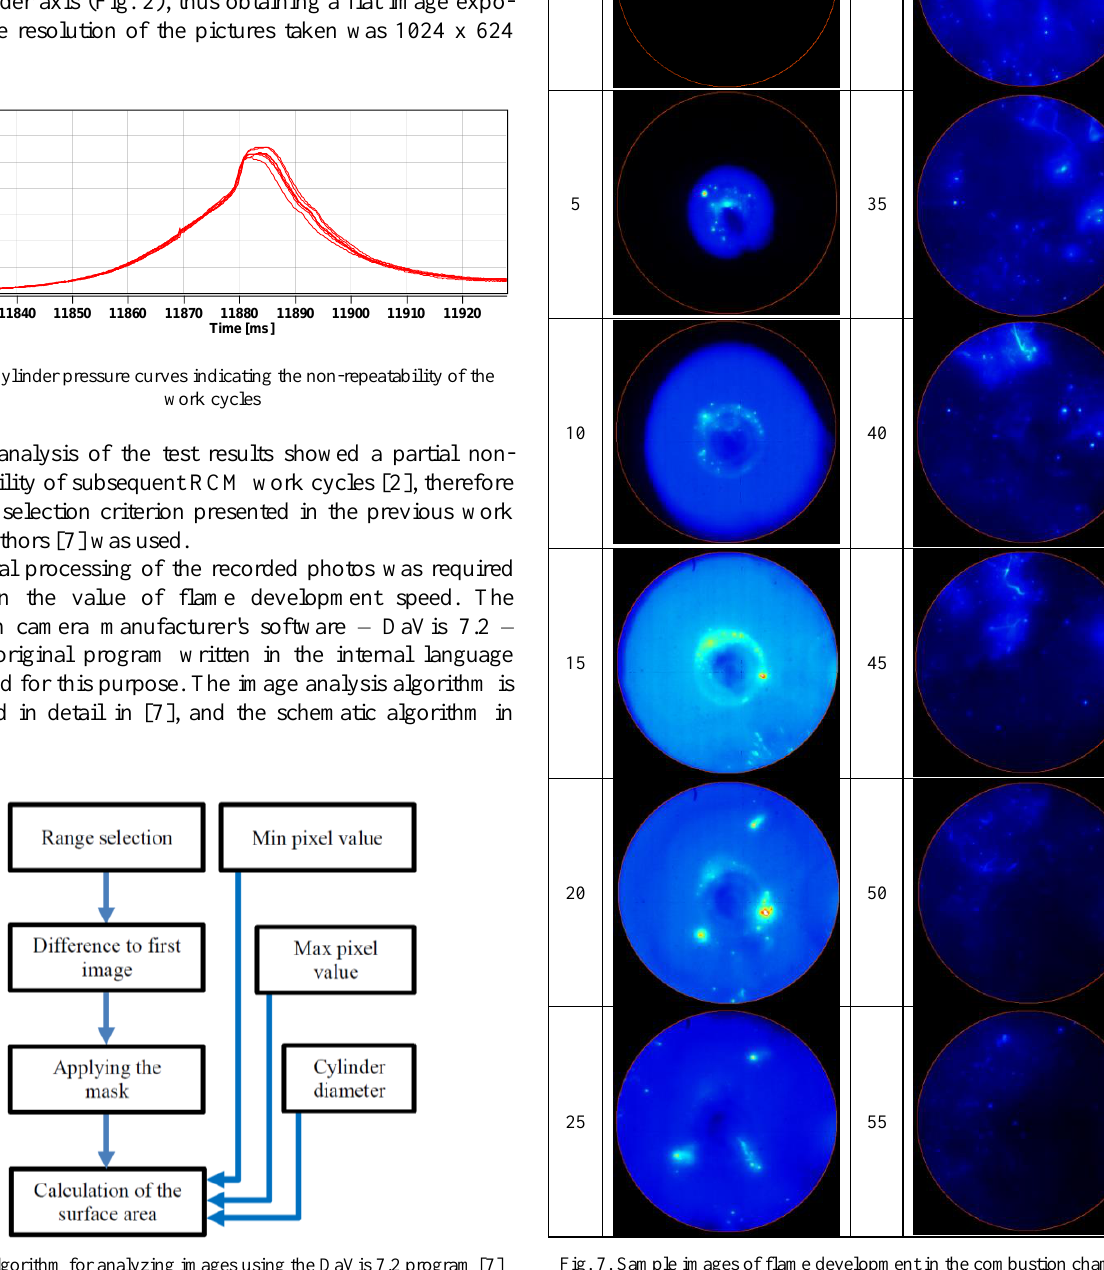
Fig. 6. Algorithm for analyzing images using the DaVis 7.2 program [7] Fig. 7. Sample images of flame development in the combustion